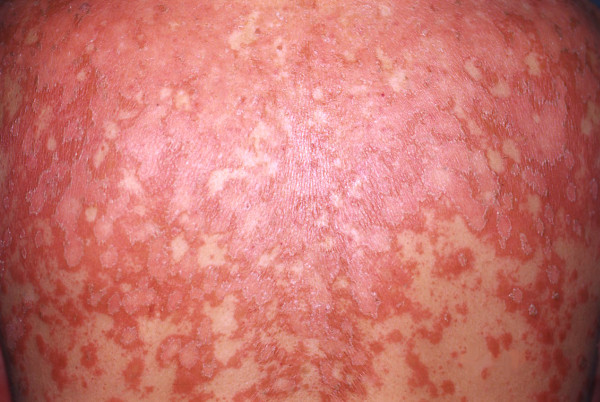
Pityriasis rubra pilaris covering the back of the second patient.